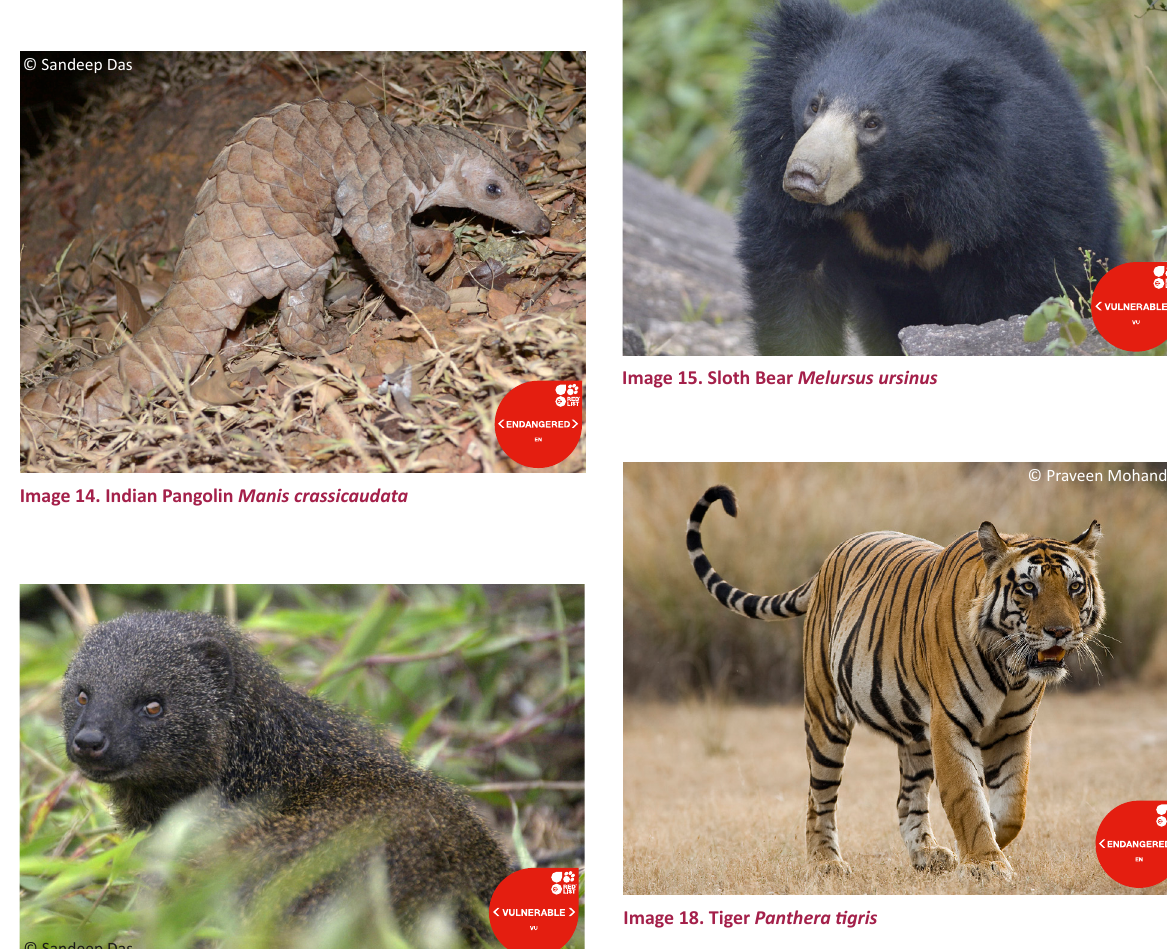
Image 12. Blyth’s Horseshoe Bat Rhinolophus